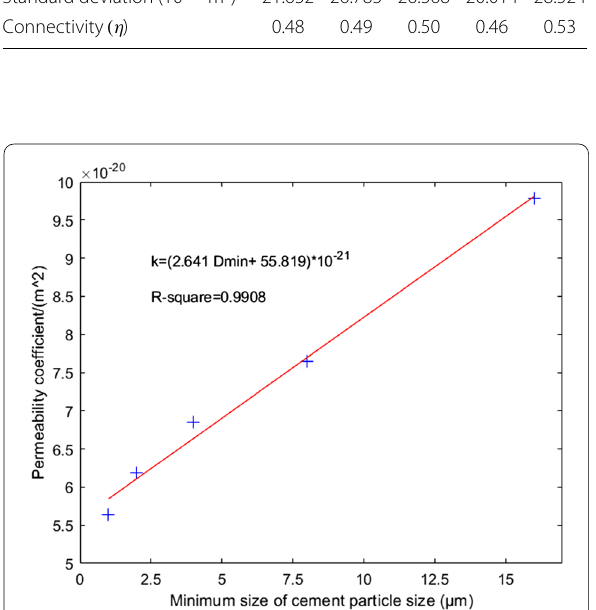
Fig. 13 Fitting curve of permeability coefficient vs. minimum size of particle.